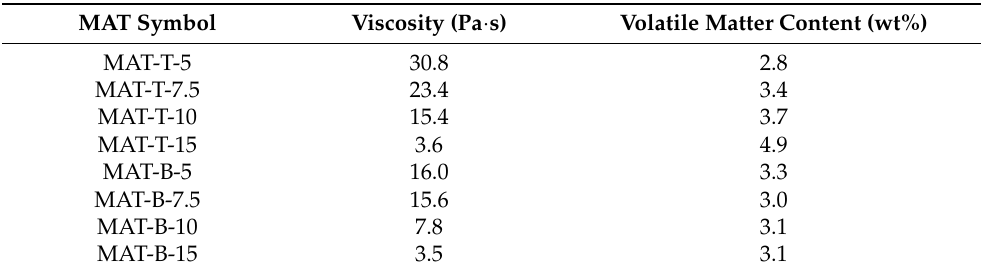
Figure 1. Theoretical chemical structures of the monomers, telogens, and acrylic telomers (MAT-T with tetrabromomethane; MAT-B with bromotrichloromethane). Table 2. Viscosity and volatile mater content vales for the MAT solutions.